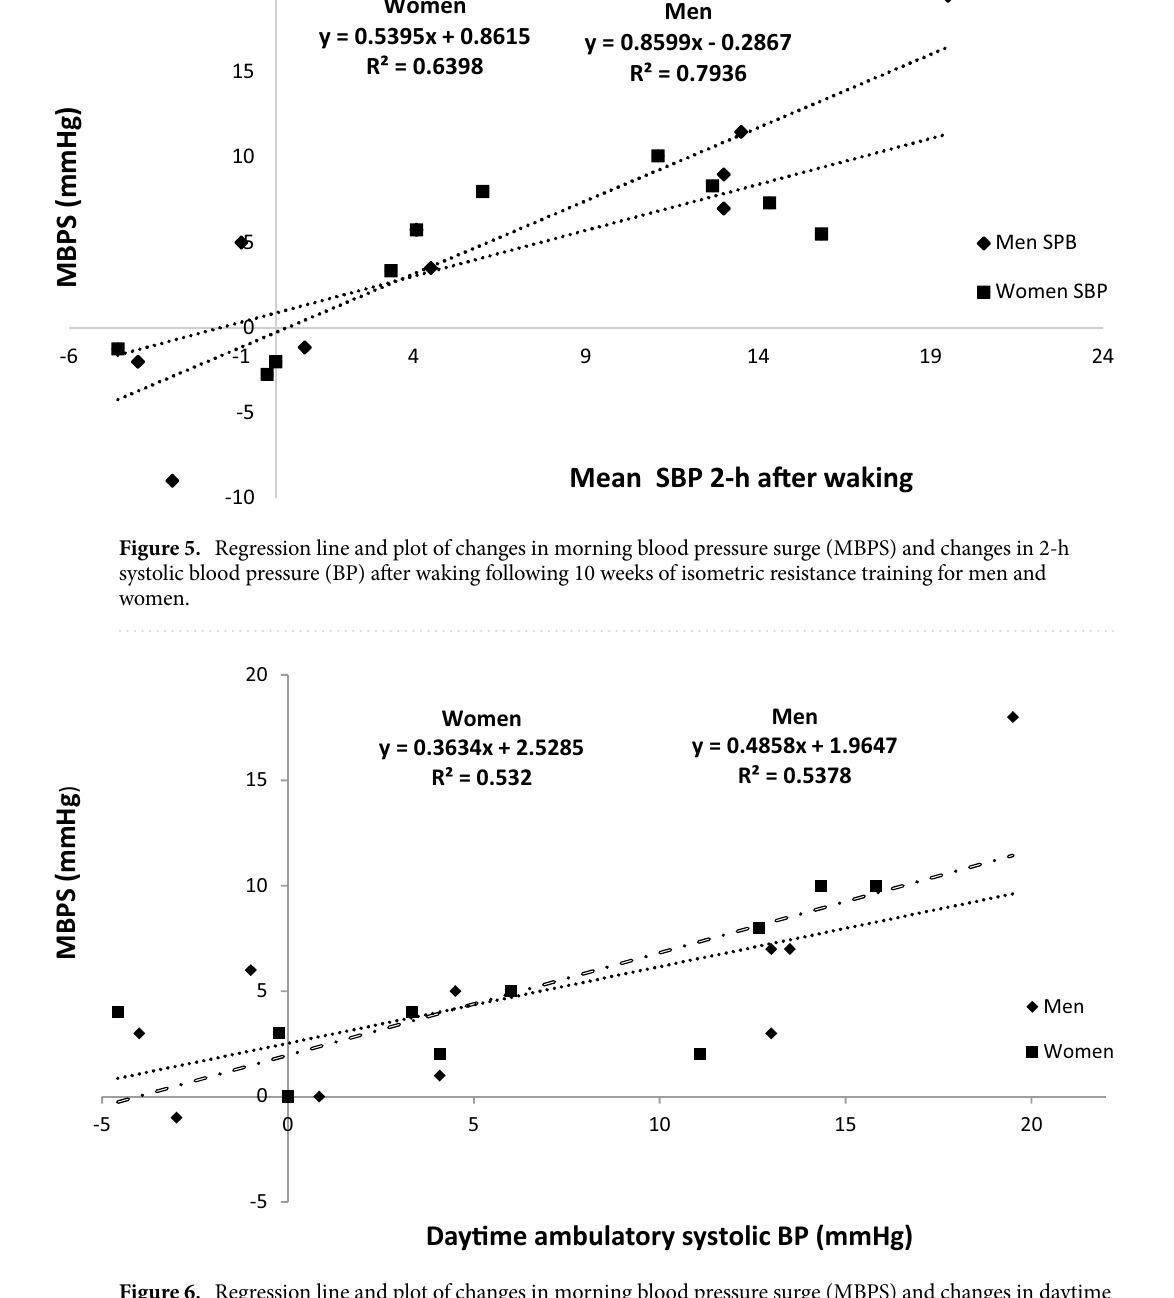
Figure 6. Regression line and plot of changes in morning blood pressure surge (MBPS) and changes in daytime ambulatory systolic blood pressure (SBP) following 10 weeks of isometric resistance training for men and